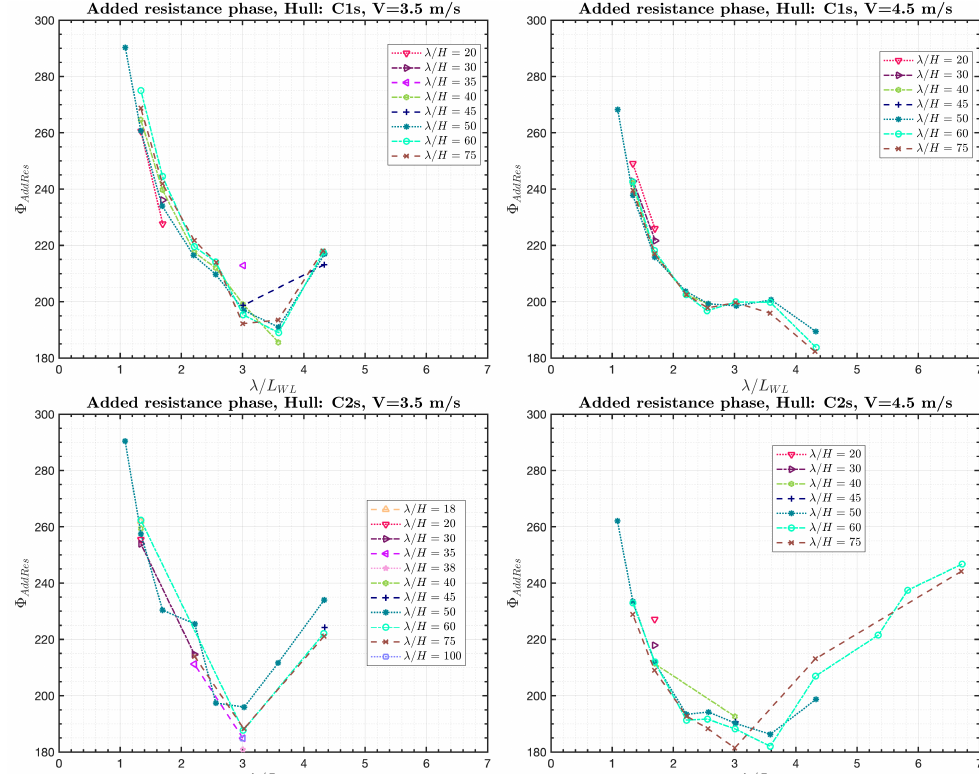
Figure 12. Added resistance phase vs. λ / L WL .